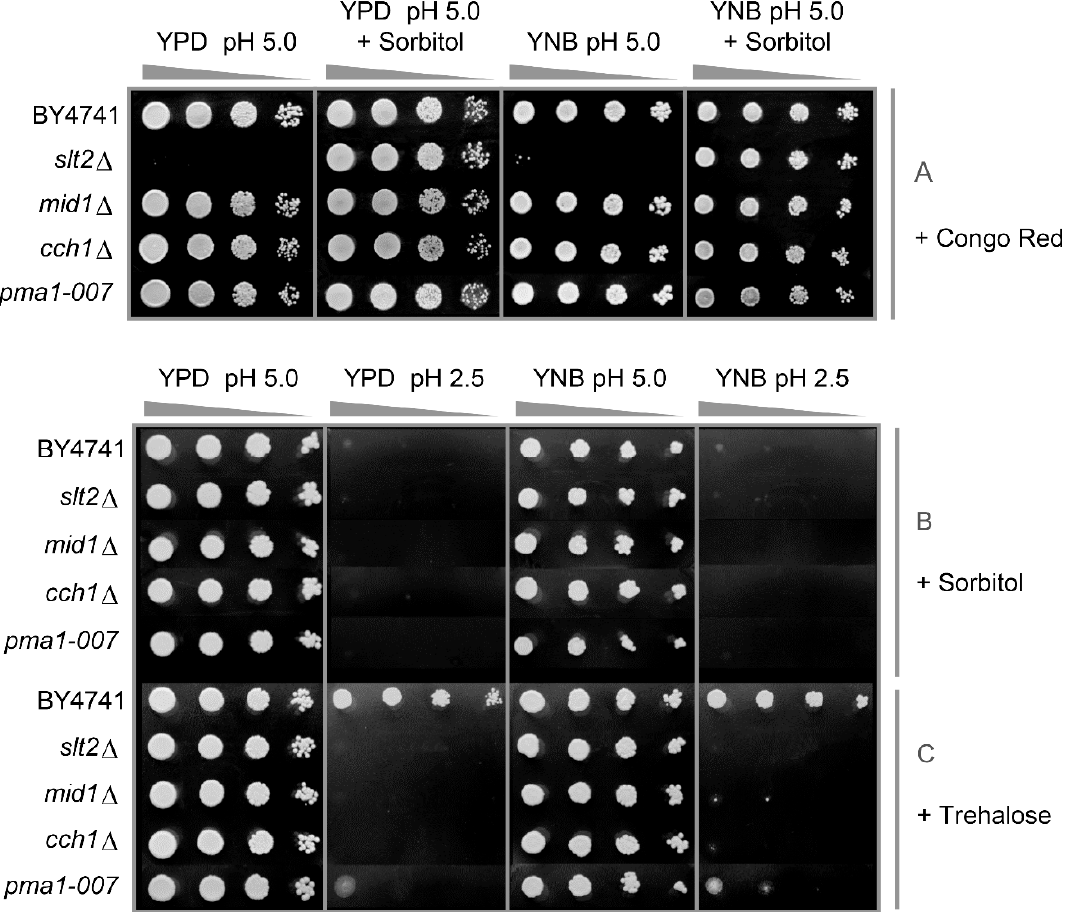
Figure 3. Analysis of the effect of cell wall protective (sorbitol or trehalose) or damaging (Congo red) agents on the tolerance of S. cerevisiae to low pH ex . Cells of BY4741 and its isogenic mutants slt2 ∆ , mid1 ∆ , cch1 ∆ and pma1-007 were cultivated in YPD and serial dilutions (1 / 10) of yeast cultures were spotted on YPD or YNB agar media adjusted to pH 5.0 or 2.5 with sulphuric acid containing Congo red 100 µ g / mL: in absence or presence of sorbitol 1 M ( A ); solely containing sorbitol 1 M ( B ); or trehalose 1 M ( C ). Plates were incubated for two days at 30 °C.